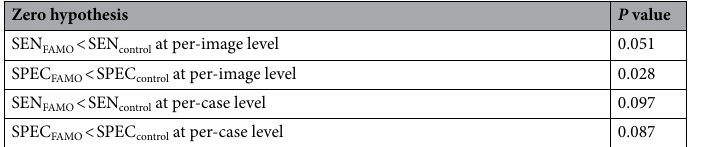
Table 3. Hypothesis test results. SEN FAMO , sensitivity of model with FAMO; SEN control , sensitivity of control model; SPEC FAMO , specificity of model with FAMO; SPEC control , specificity of control model; P value, the probability to obtain a result as extreme as that in the hypothesis test which assumed that FAMO performance was worse than the control model.